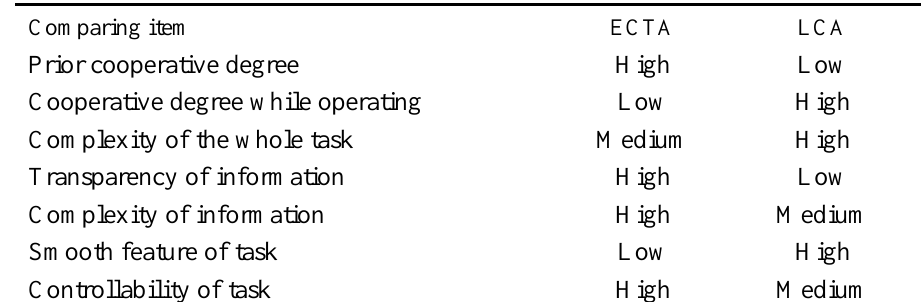
Table 1. Comparison on advantages and disadvantages between Extension Case Transmission (ECTA) and Loosen Couple (LCA)